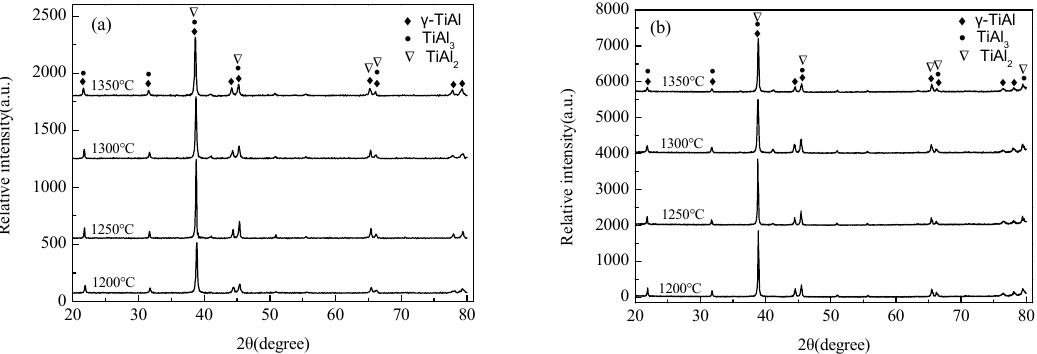
Figure 7. Isopleth of the Ti-Al-Nb ternary system at Nb = 8 at% based on database given in [23]. Red dotted line shows the phase transformation path of the nominal composition Ti-48Al-8Nb (at%). Full triangle represents 1350 ◦ C, 1300 ◦ C, 1250 ◦ C and 1200 ◦ C from top to bottom.